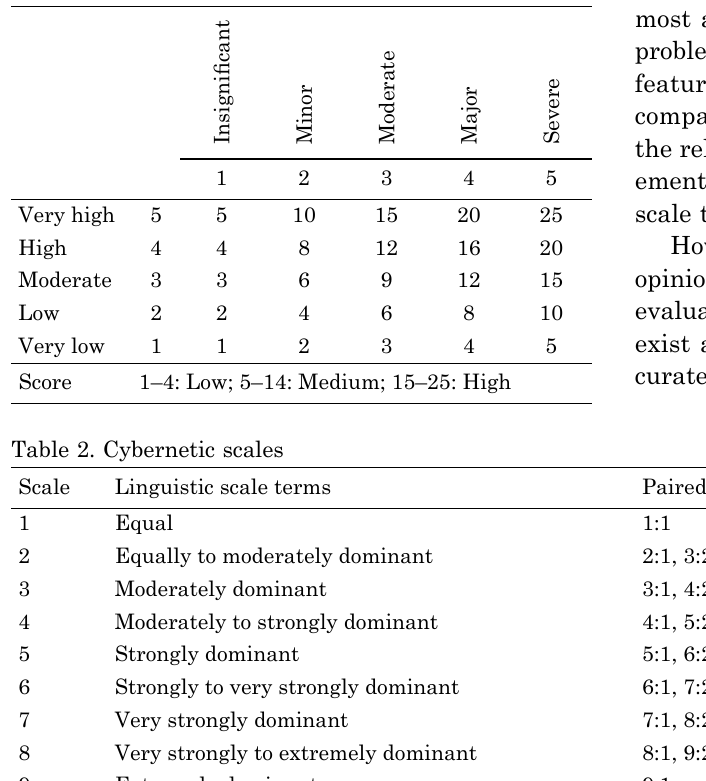
Table 1. Risk analysis matrix Frequency